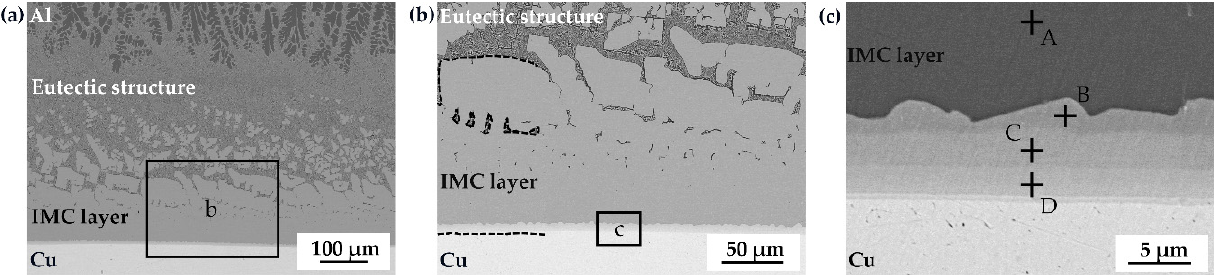
Figure 4. ( a ) Backscattered electron (BSE) image of the interfacial region with a reaction layer, ( b , c ) highly magnified BSE images of the intermetallic compound (IMC) layer located above the Cu in the Al/Cu dissimilar joint without alloying elements. Table 3. Chemical compositions of the IMC phases formed without alloying elements indicated in Figure 4. Content (at.%) Location Phase